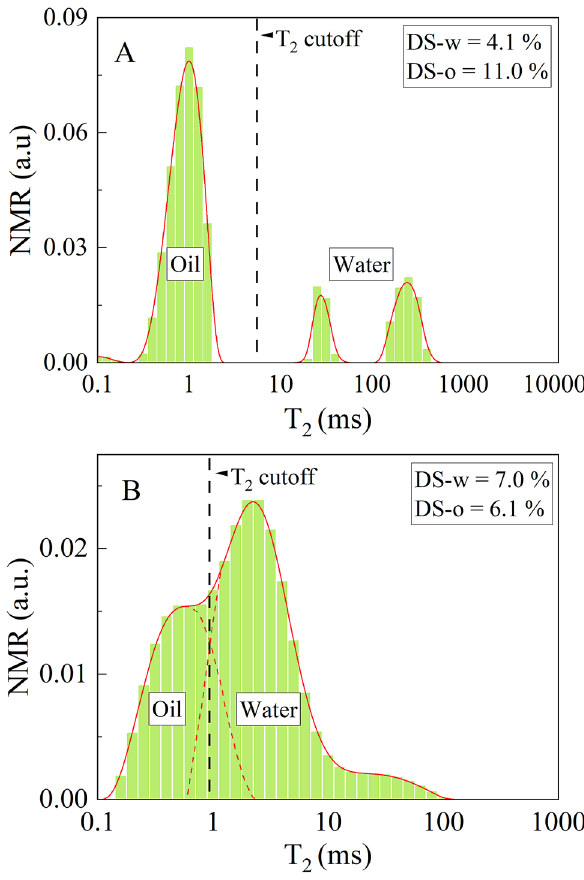
Figure 1. Representative NMR T 2 distributions of two oil-sand samples. ( A ) An example of distinct oil and water signals where a simple cutoff method can be used for oil–water separation. ( B ) An example of NMR T 2 distribution with overlapped oil and water signals where deconvolution with T 2 cutoff cannot provide a satisfactory solution. Black vertical dashed lines present potential cutoff times. DS-w and DS-o are percentages of water and oil by Dean-Stark, respectively, relative to